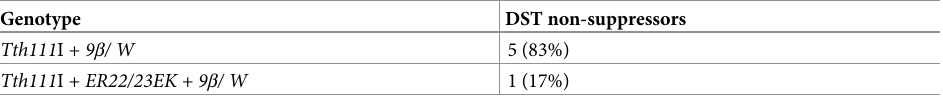
Table 4. Pharmacogenomic markers of glucocorticoid resistance in 21-OHD subjects (n =